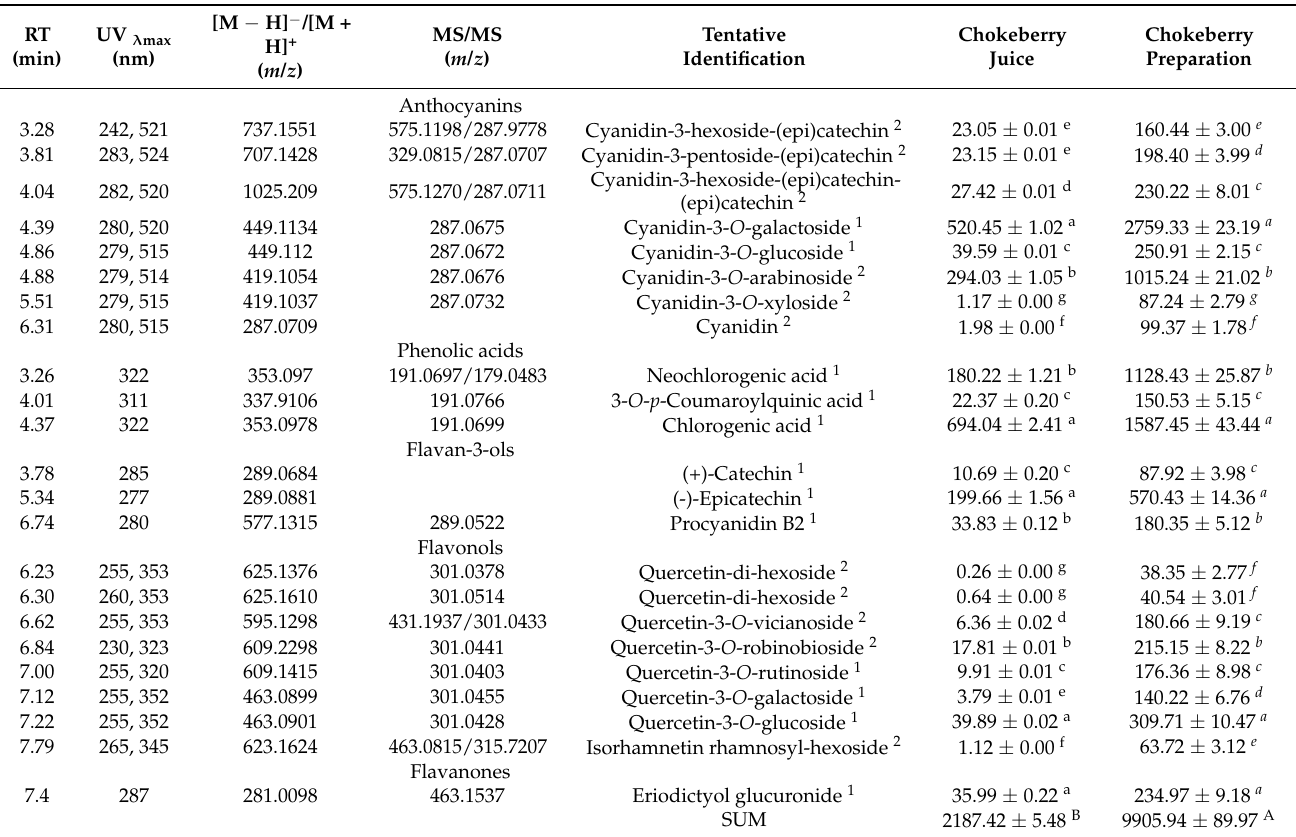
Table 1. Profile and quantity (mg/100 g of product) of phenolic compounds in chokeberry juice and phenolic